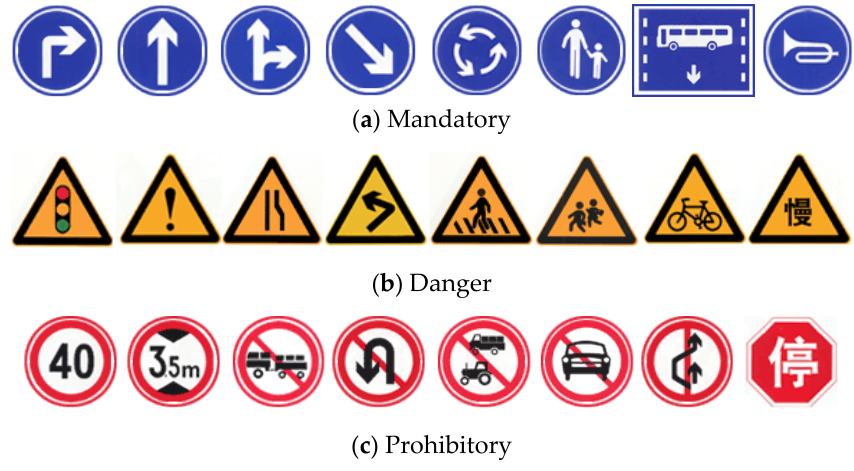
Figure 3. Samples of the three super categories in China.